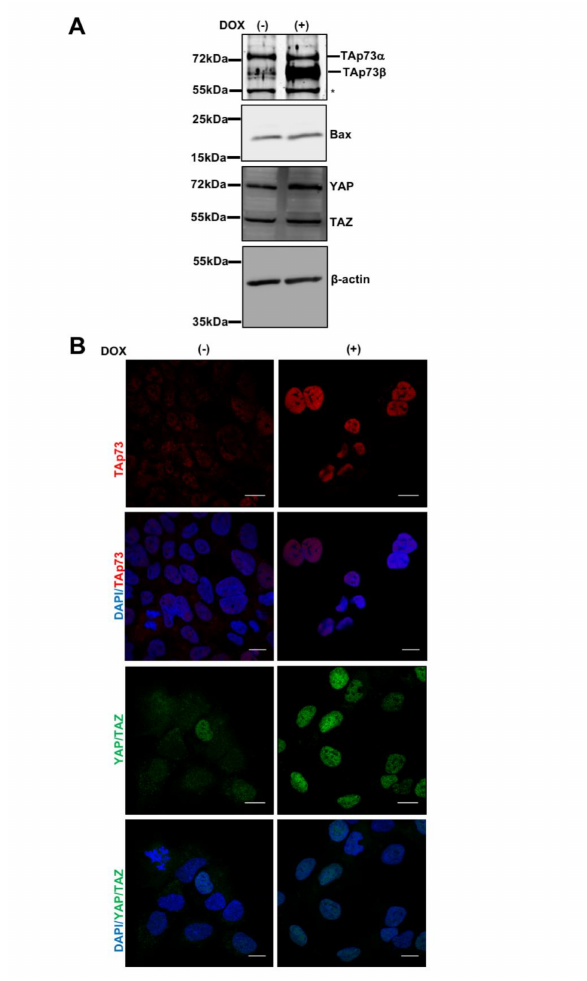
Figure 4. TAp73 β activates expression and nuclear localization of YAP, but does not affect Bax expression. ( A ) Hep3BTAp73 β cells were treated with doxycycline (1 µ g/mL) for 72 h and cell lysates were obtained, then western blot was performed for p73, YAP and Bax expression. β -actin was used as a loading control (n = 2). * Non-specific signals. ( B ) Upon TAp73 β induction, both TAp73 and YAP show nuclear accumulation (*). Immunofluorescence assay was performed to determine the expression and localization of p73 (Red), YAP (Green), respectively in Hep3BTAp73 β cells treated with Doxycycline (1 µ g/mL) for 72 h. DAPI (blue) was used for nuclear counterstain. Images were taken at x63 magnification in a confocal microscope. Scale bar = 20 µ m. * Please note that the antibody used for TAp73 β immunofluorescence recognizes all p73 isoforms [27]. Similarly, D24E4 antibody used for YAP immunofluorescence also detects TAZ